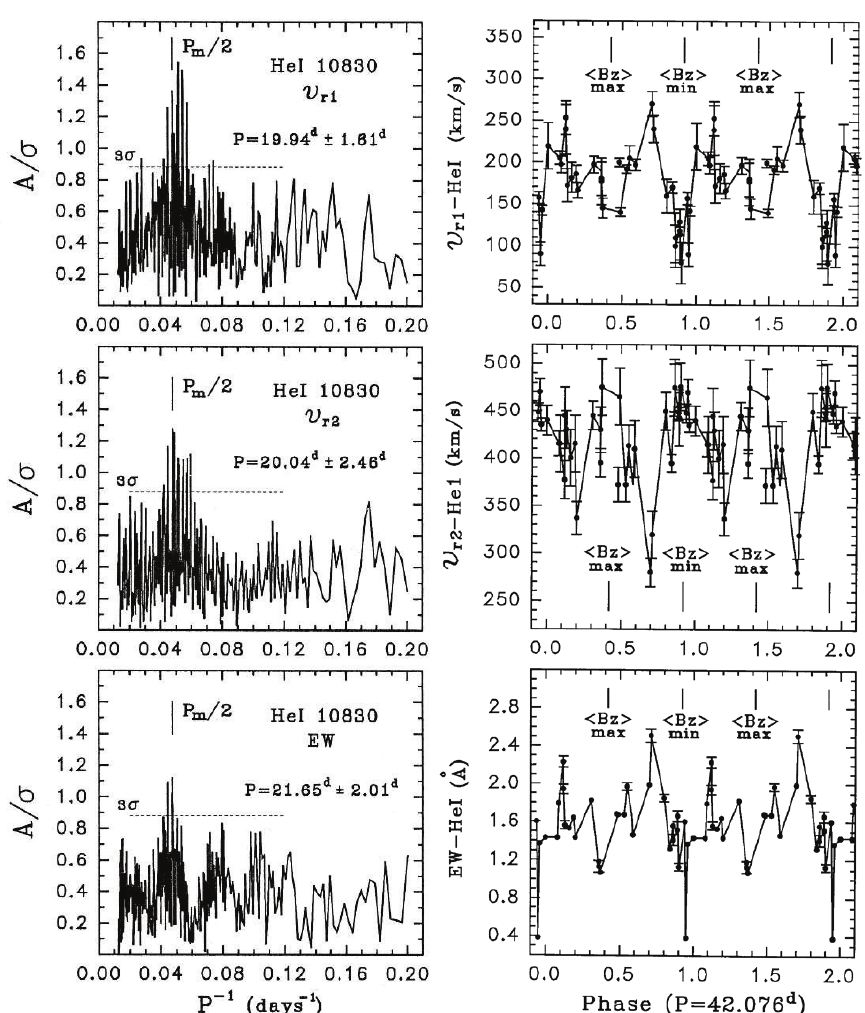
Figure 3. Left : A / σ periodograms for different parameters of the He I λ 10830 line shown in Figure 2. The 3 σ significance levels are marked by dashed lines. Short vertical lines indicate the value corre- sponding to half of the rotation period ( P rot /2 = 21. d 04). Right : Phase dependencies of different line parameters over the rotation period P m = 42. d 076. The initial phase φ = 0 corresponds to MJD52797.4. Credit: Schöller et al., A&A, 592, A50, 2016, reproduced with permission ©